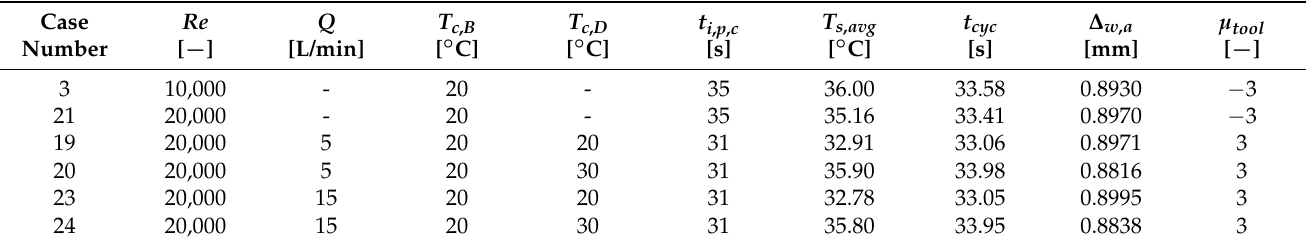
Figure 8. Three-dimensional Pareto frontier without the tool-efficiency index objective ( a ) and two- dimensional Pareto frontiers for individual objectives plotted against the tool-efficiency index ( b – d ). Table 6. The Pareto frontier calculation cases with variable values and